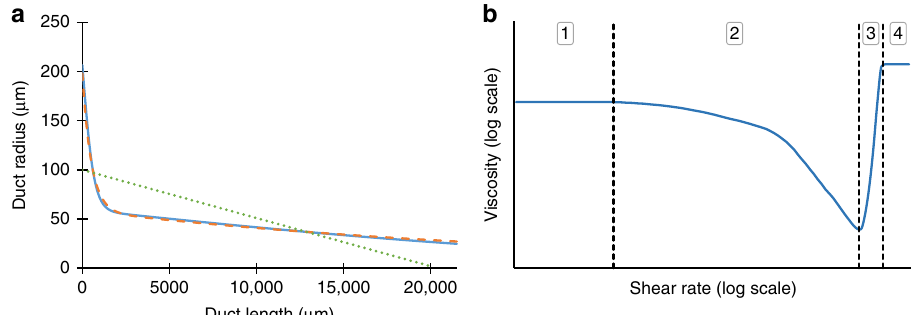
Fig. 2 Geometric and rheological considerations. a Previous geometric approximations of silk ducts showing the variation in radius as a function of distance along the duct. Curves represent Asakura ( orange dashes ) and Breslauer ’ s ( blue line ) hyperbolic approximations, along with the linear model employed by Kojic ( green dots ). The equations describing each curve can be found in Supplementary Table 1. b – Exemplar rheological response of silk feedstock to increasing shear rate, showing four distinct regimes - (1) – Pseudo-Newtonian behaviour at low shear rates; (2) – Shear thinning behaviour; (3) – Fibrillation, increasingly elastic response; (4) – Viscoelastic solid, second plateau reached